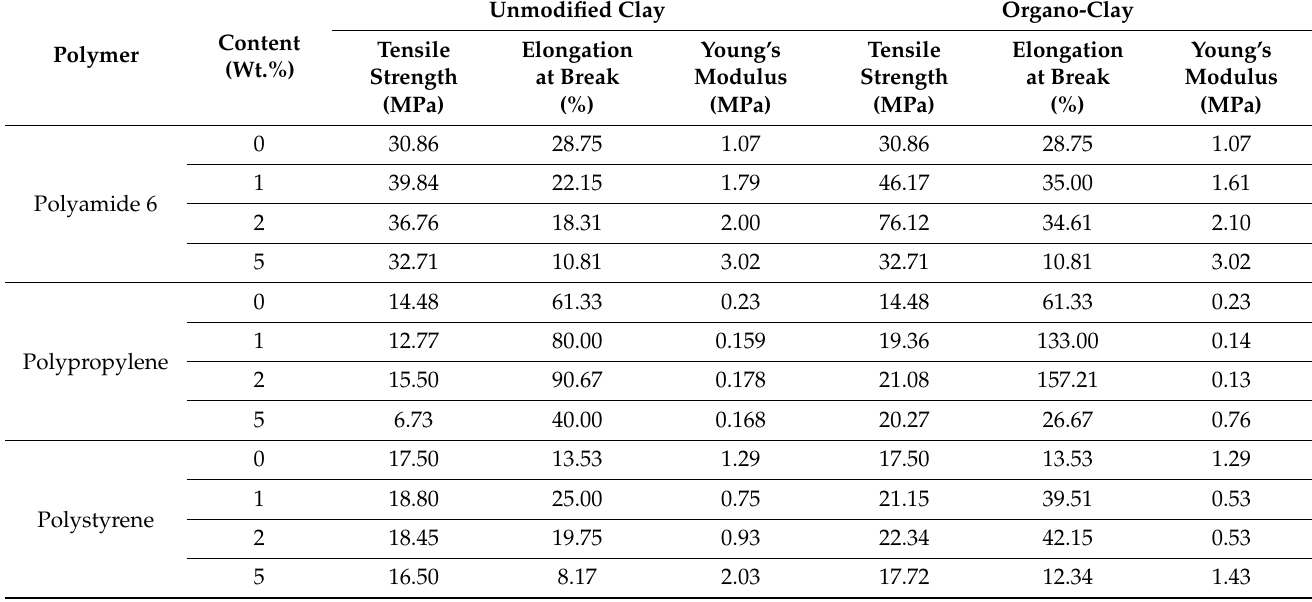
Table 2. Mechanical properties of some polymer–clay